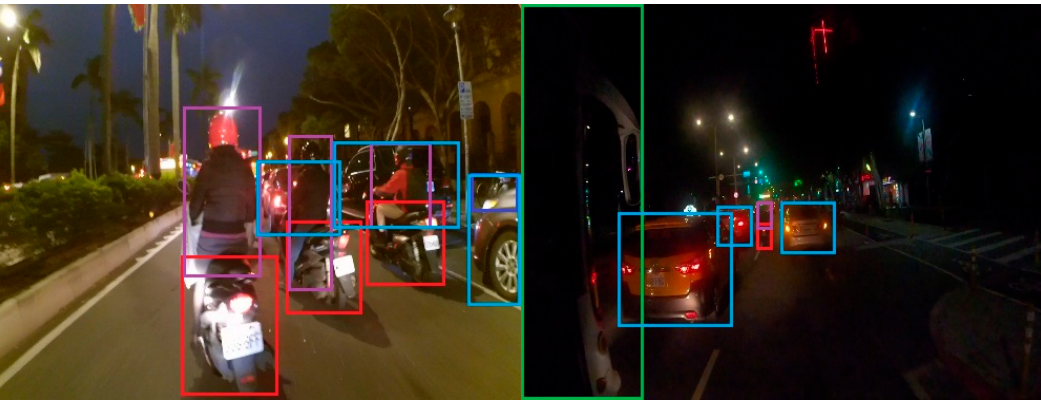
Figure 6. Two labeling samples. Left : Brighter nighttime image. Right : Darker nighttime image.